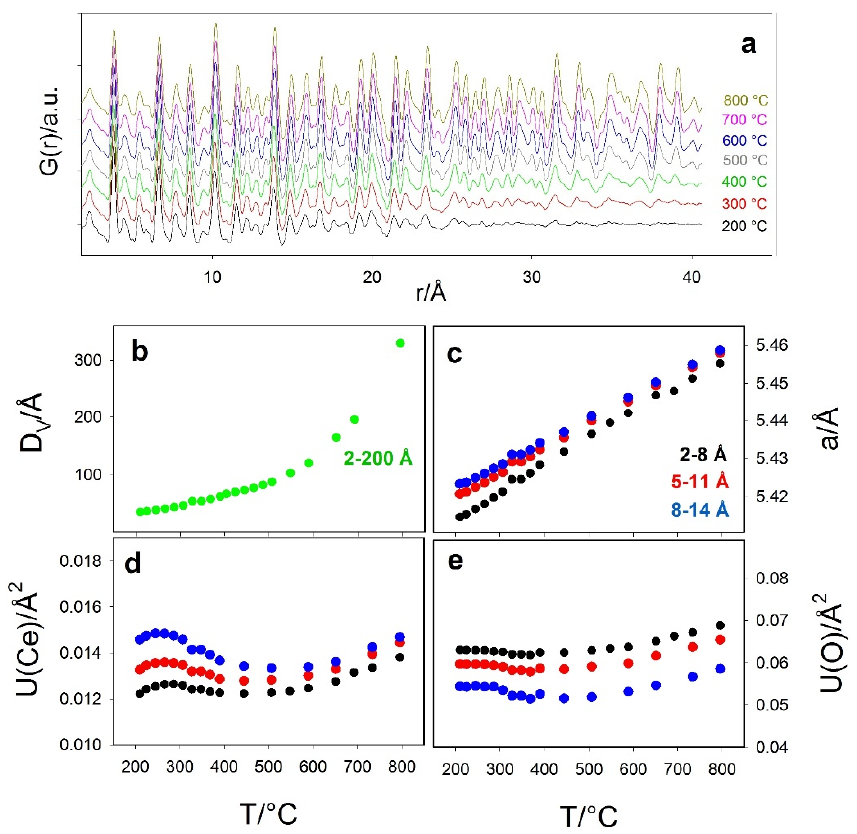
Figure 7. ( a ) Selected experimental G( r ) collected in situ while heating Ce200 sample at 10 °C/min. ( b – e ) selected refined parameters as a function of T: ( b ) particle diameter, ( c ) cell constant, ( d ) displacement parameter Ce and ( e ) O. Black, red, blue and green circles refer to refinements in the 2–8 Å, 5–11 Å, 8–14 Å and 2–200 Å r intervals, respectively.